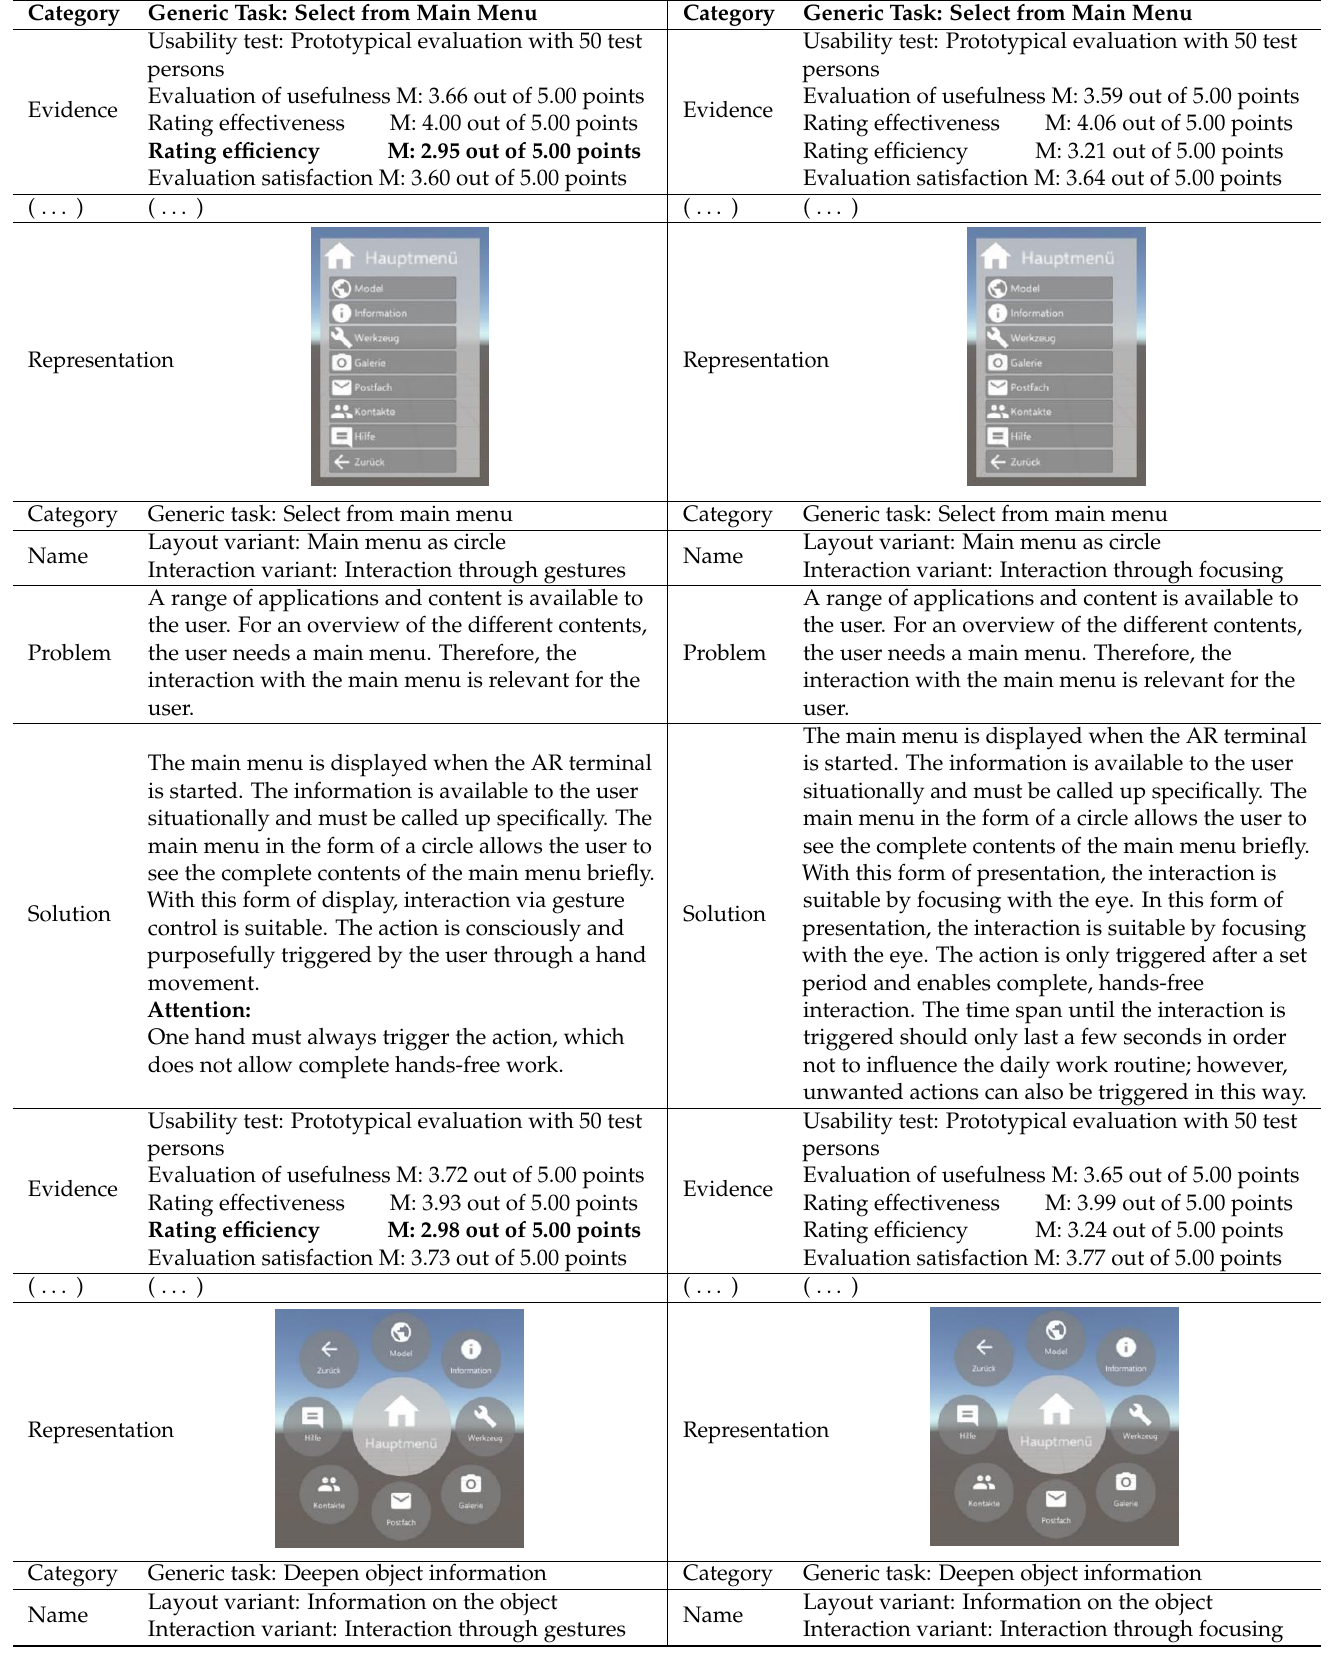
Layout variant: Information on the